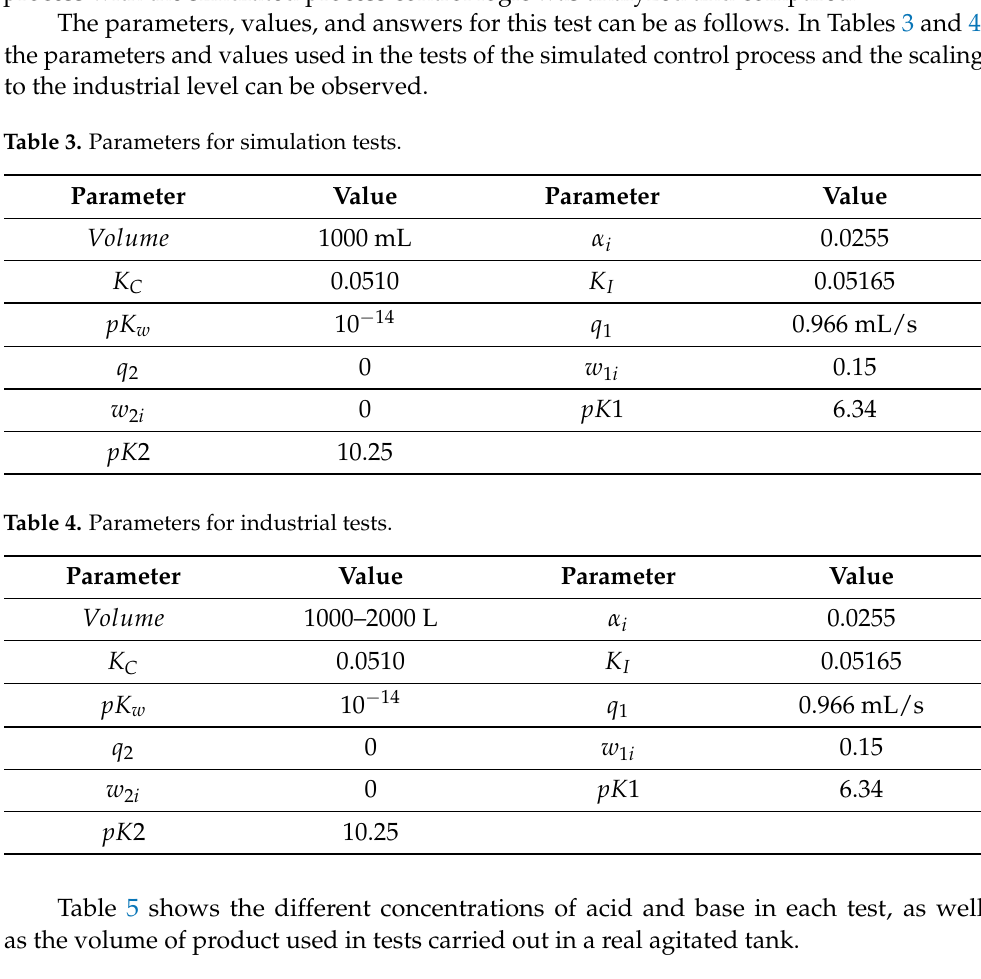
Table 5. Concentrations and volume for tests in agitated